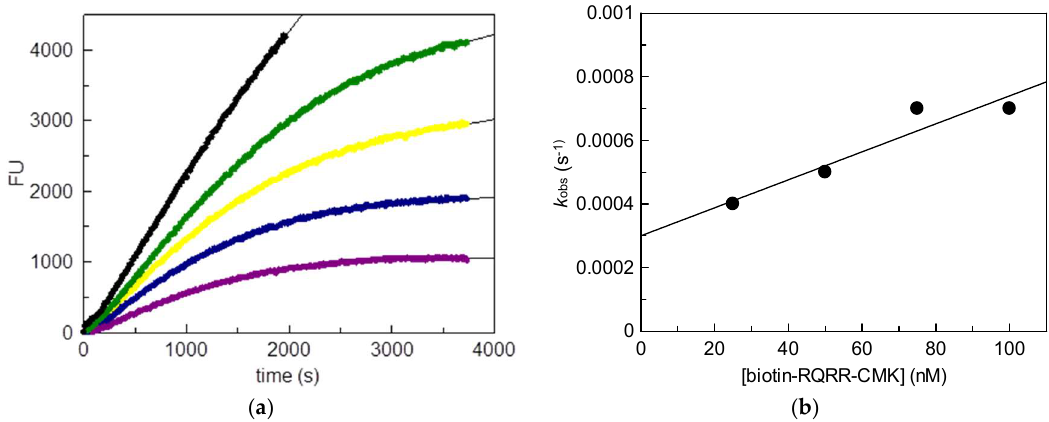
Figure 2. Matriptase-2 (MT-2) activity in the supernatant of transfected human embryonic kidney (HEK) cells in the presence of increasing concentrations of biotin-RQRR-CMK: ( a ) Fluorescence units (FU) plotted vs. time. Colored progress curves represent reactions in the presence of different probe concentrations (● uninhibited reaction; ● 25 nM; ● 50 nM; ● 75 nM; ● 100 nM); ( b ) Values k obs plotted vs. probe concentrations.